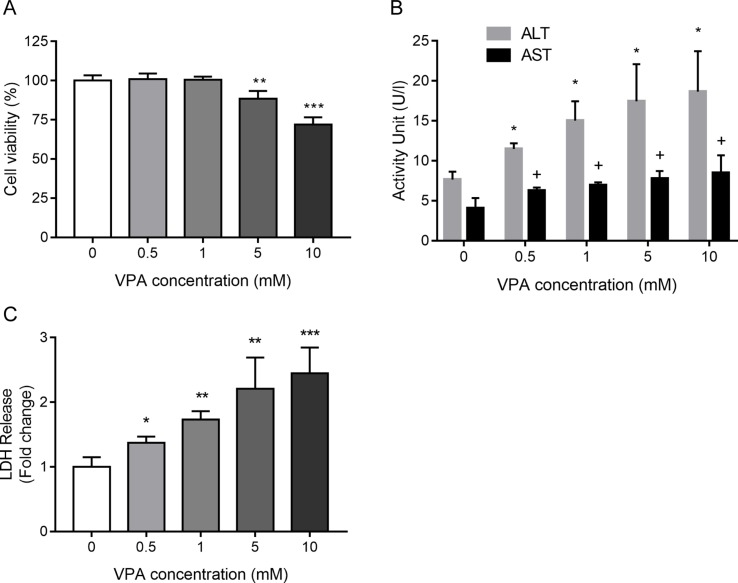
The toxic effect of VPA on cell viability (A), ALT and AST activity (B), and the activity of LDH (C) in the culture medium collected from L02 cells treated by VPA. L02 cells were exposed to different concentrations of VPA (0, 0.5, 1, 5, and 10 mM) for 24 h in vitro. Data are expressed as mean ± SD (n = 3); *P < 0.05, **P < 0.01, and ***P < 0.001 compared with control group regarding cell viability and ALT levels; #
P <0.05 compared with control group regarding AST levels.